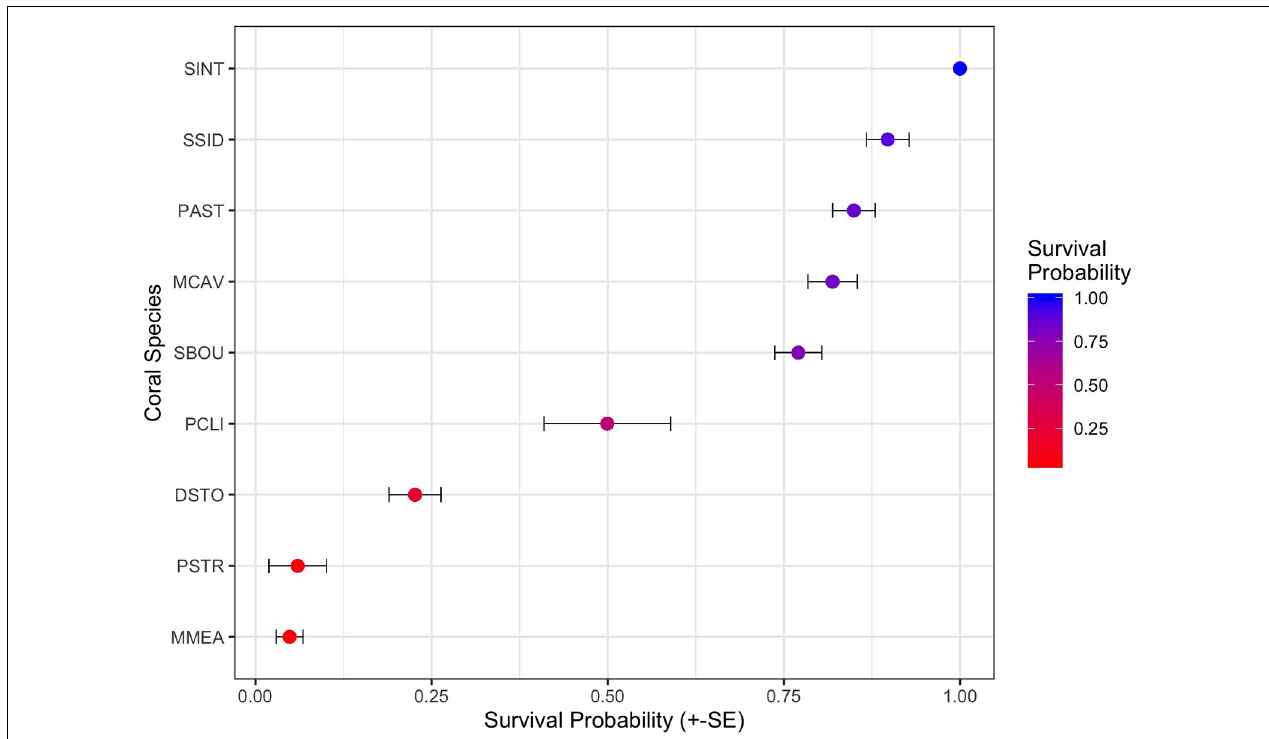
FIGURE 6 | Twenty One-month survivorship probabilities (+/– standard errors) across the nine most common coral species in the monitoring data. Nine species include Stephanocoenia intercepta (SINT), Siderastrea siderea (SSID), Porites astreoides (PAST), Montastrea cavernosa (MCAV), Solenastrea bournoni (SBOU), Pseudodiploria clivosa (PCLI), Dichocoenia stokesi (DSTO), Psuedodiploria strigosa (PSTR), Meandrina meandrites (MMEA), and are ranked by the highest to lowest mean survival.